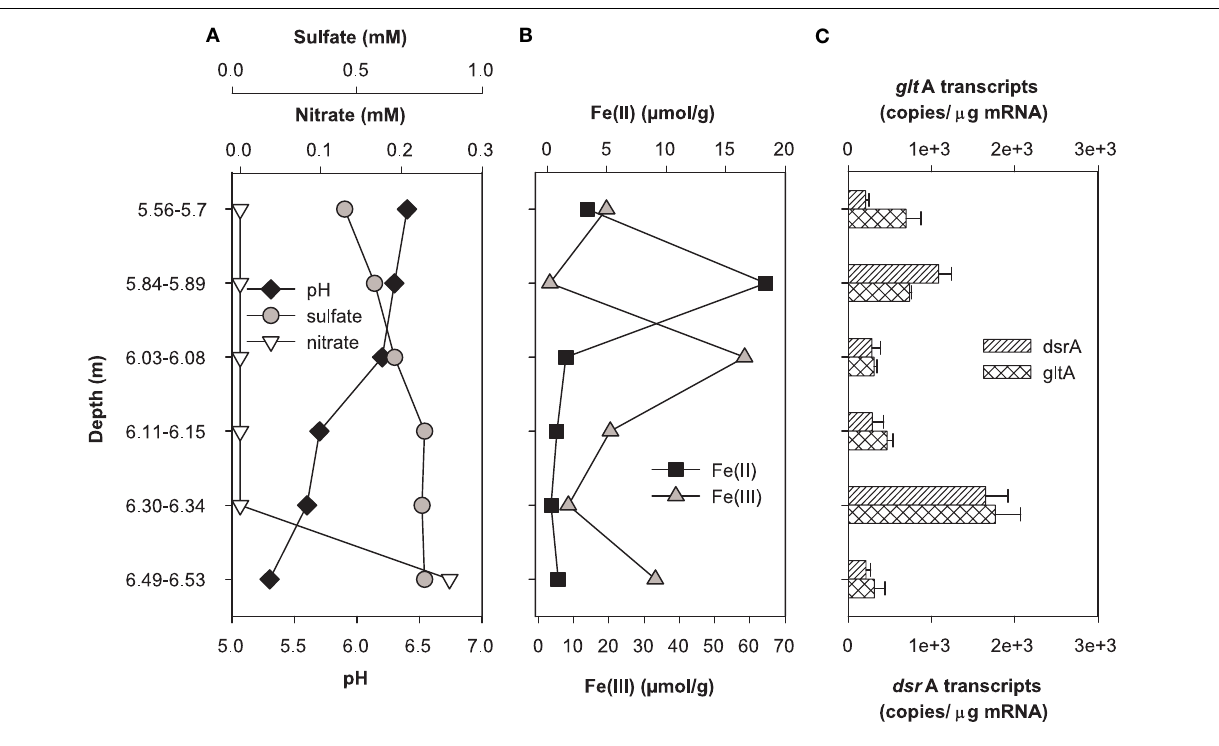
FIGURE 4 | Geochemistry (A,B) and levels of dsr A and glt A transcripts (C) in the depth interval from 1.23 to 15.08m ofArea 2 borehole FB107. Values for transcript levels are means ± standard deviations of triplicate